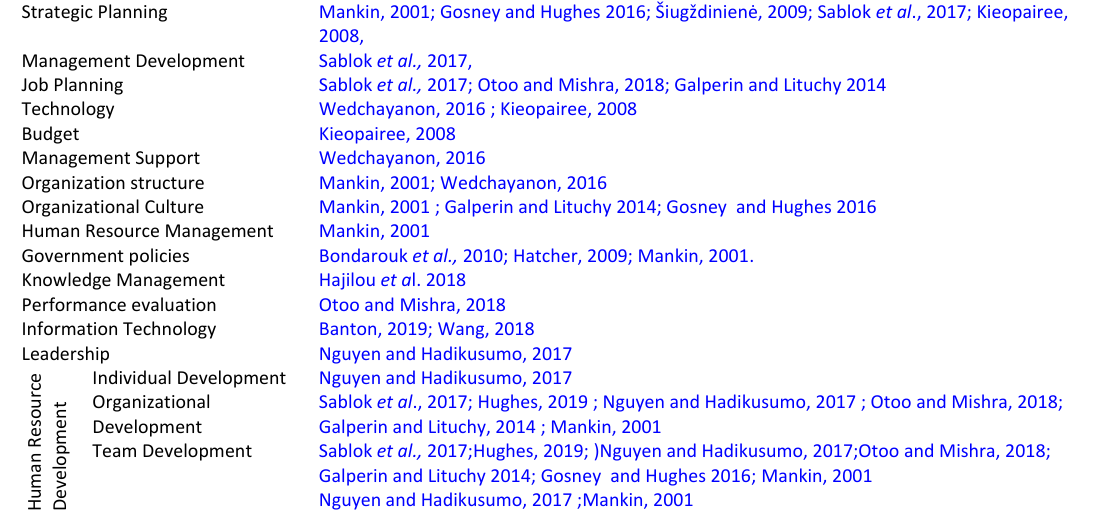
Table 2. The dimensions and factors effective on HRD